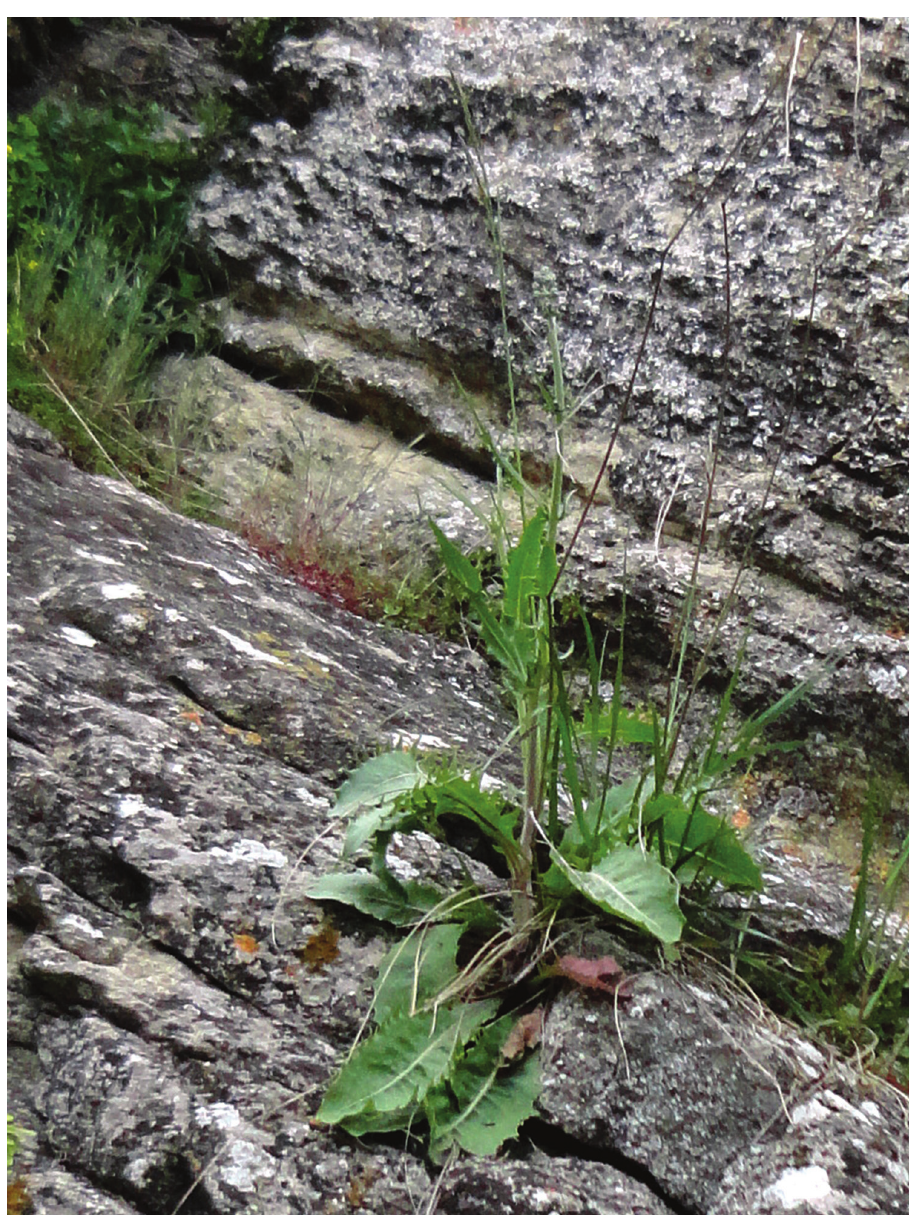
Figure 1. Individual in bud of Crepis lacera subsp. titani on limestone cliffs of Monte Titano (San Marino Republic). Photograph by L.